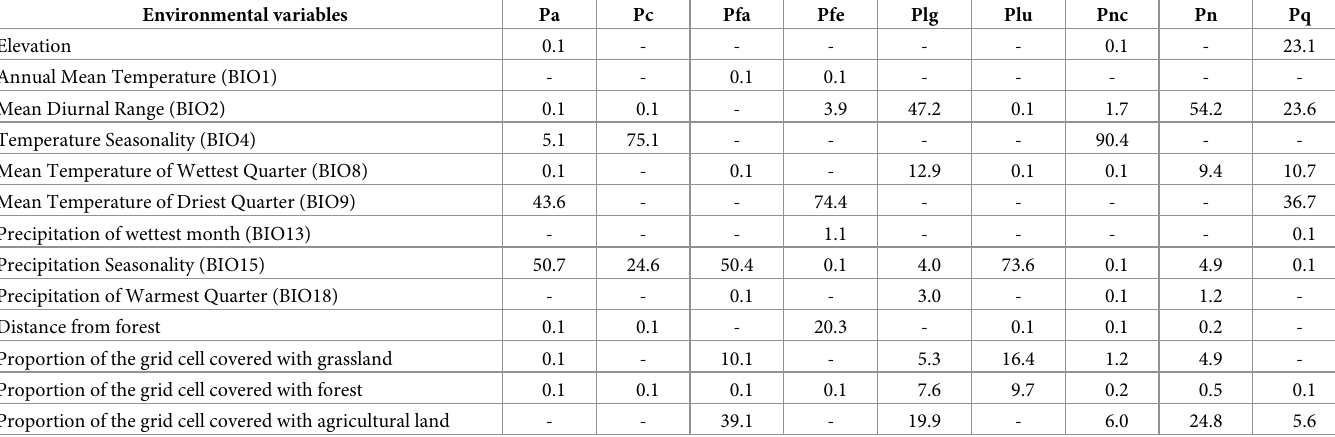
Table 1. Percentage contributions of the studied variables to the modelled distribution of Pipiza species. Environmental